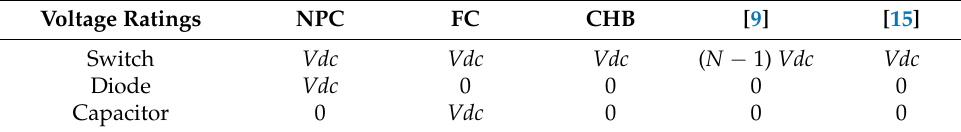
Table 5. Voltage rating of other multilevel inverter